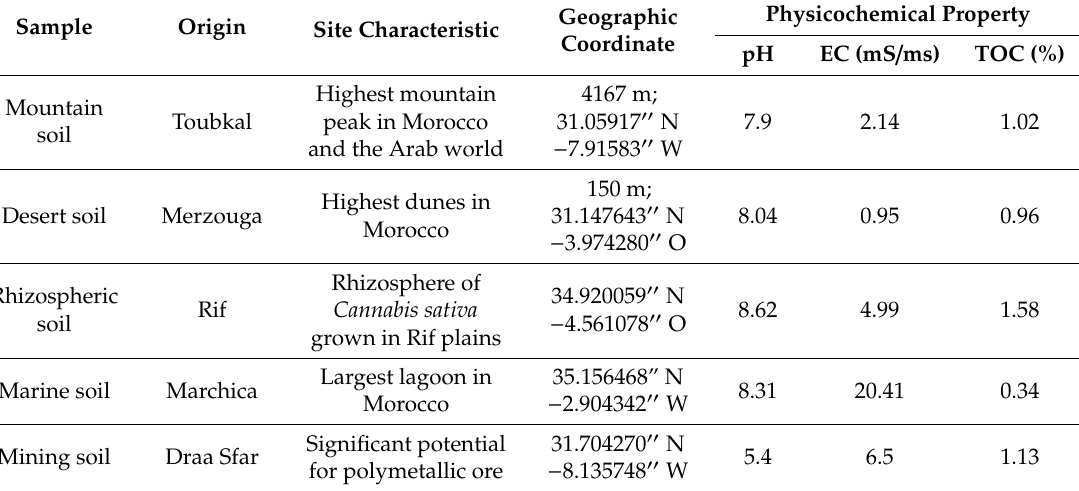
Table 1. Origins and characteristics of the five Moroccan sites